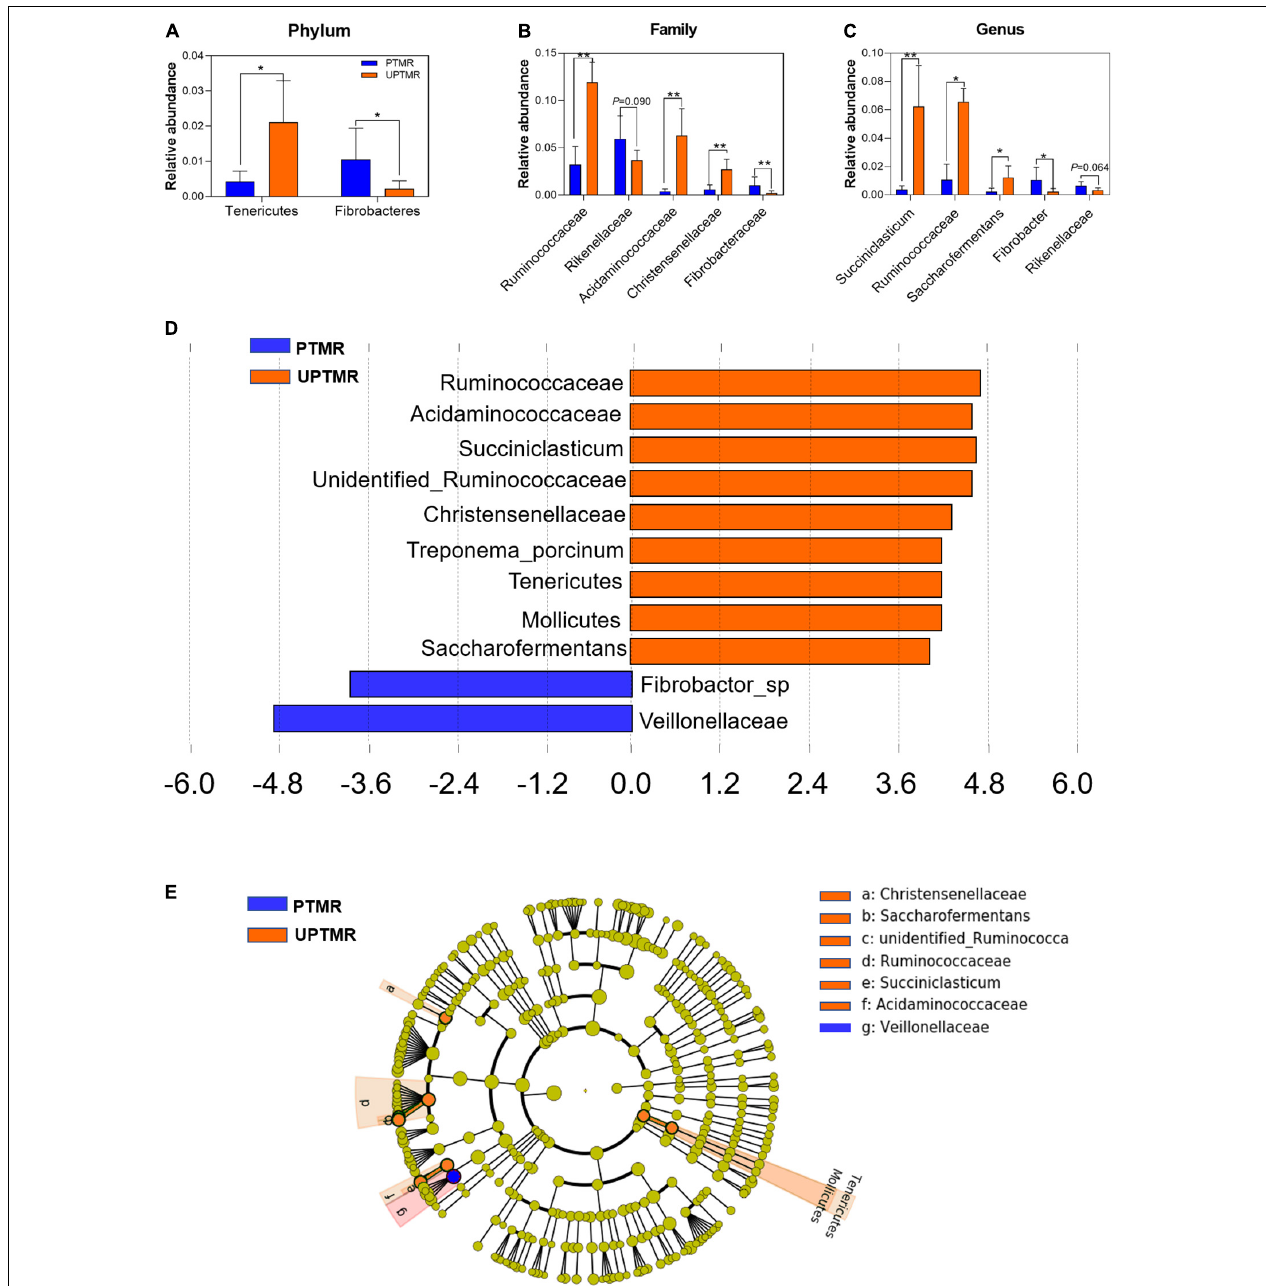
FIGURE 2 | The relative abundances of ruminal microbiota that were significantly different between the LE and HE groups at the (A) phylum, (B) family, and (C) genus levels. Only microbes that had a relative abundance of more than 0.1% were compared. Linear discriminant analysis (LDA) value distributed histogram and cladogram of different microorganisms (LDA score > 3.5). (D) Linear discriminant analysis (LDA) value distributed histogram. (E) Cladogram constructed to visualize the microbial community relative abundance data of ruminal samples between the PTMR and UPTMR groups. Different color nodes indicate different groups and the species classifications at the phylum, class, order, family, and genus levels are shown from the inside to the outside. Difference was declared to be statistically significant when * P < 0.05, ** P <